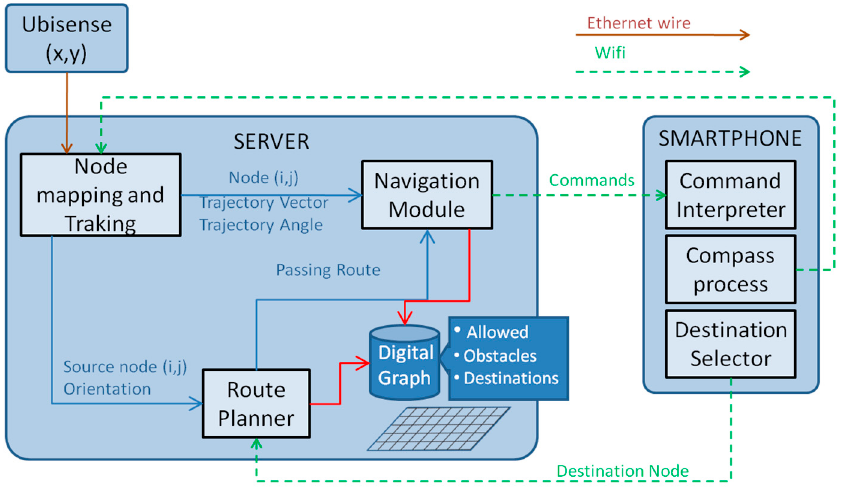
Figure 2. Architecture of the system.